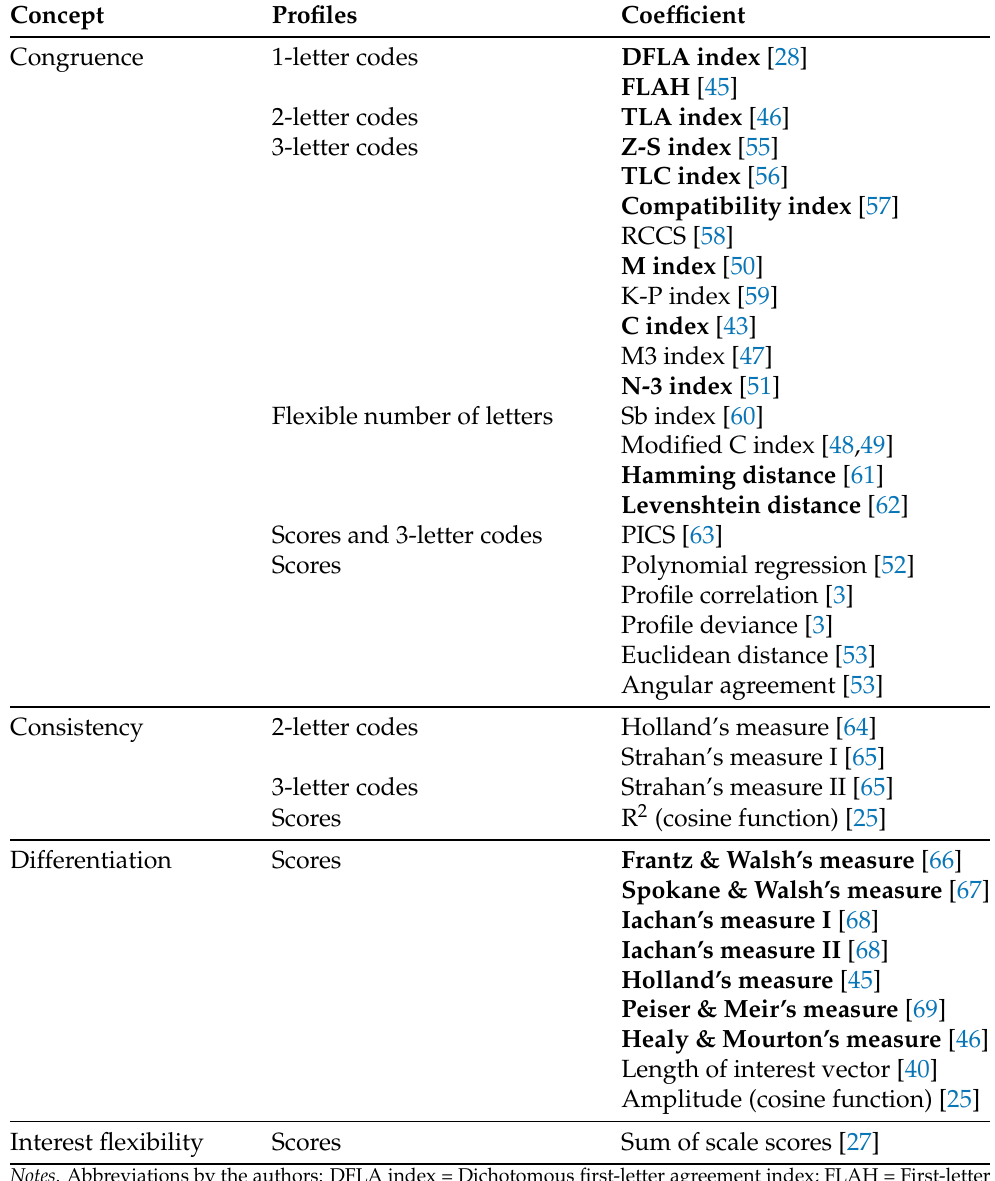
Table 1. Concepts and corresponding coefficients based on Holland’s [1] RIASEC